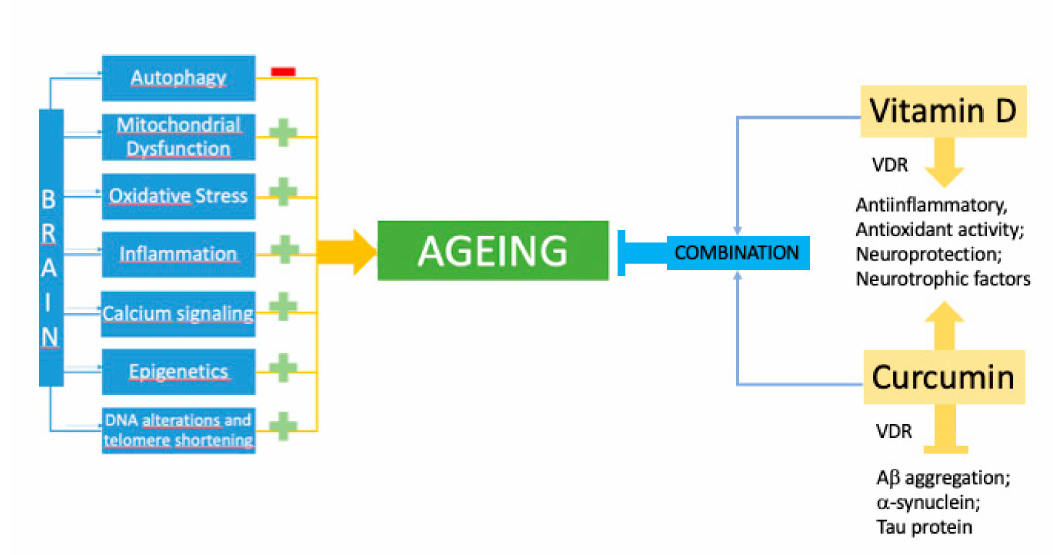
Figure 1. Schematic representation of the combined e ff ects of vitD and curcumin to slow down brain aging. VDR: vitamin D